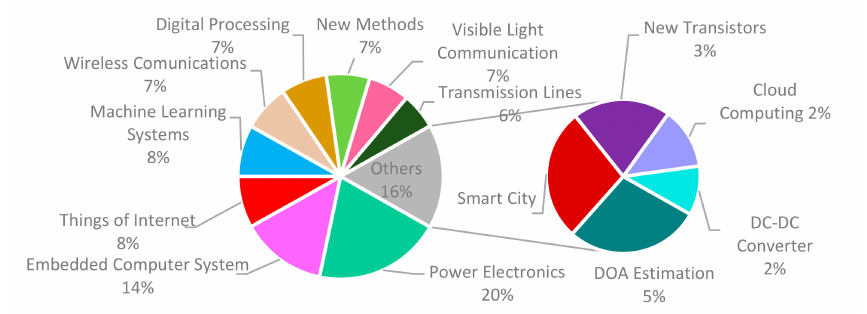
Figure 8. Representation of the paper distribution in each of the communities.